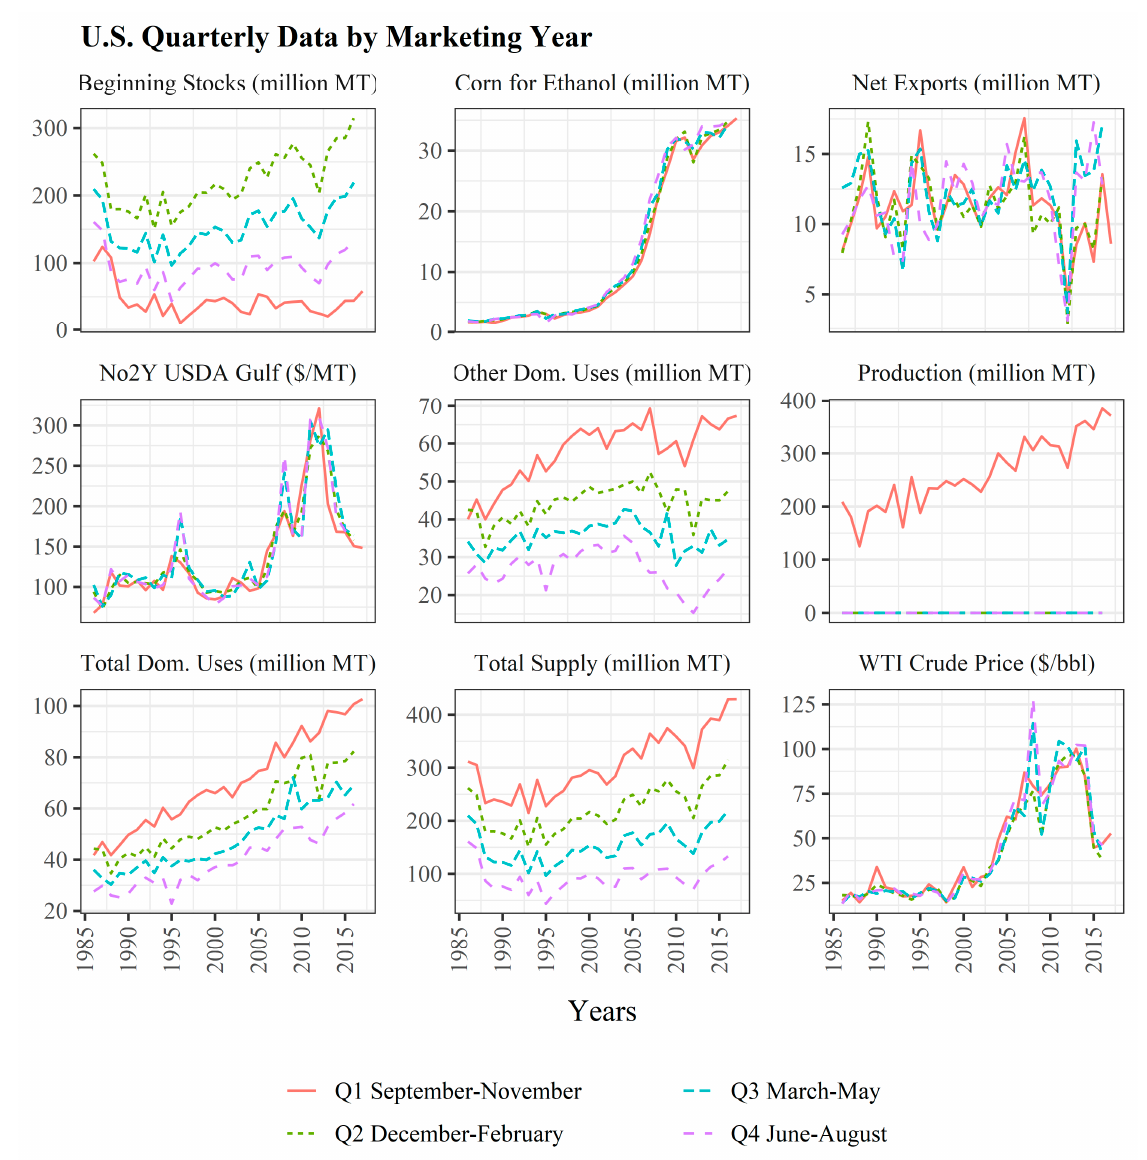
Figure 1. U.S. quarterly corn market and other data by corn marketing year. Note different scales on charts. The price of yellow corn as reported at the key export port (No2Y Corn Gulf) represents global corn prices for this analysis.